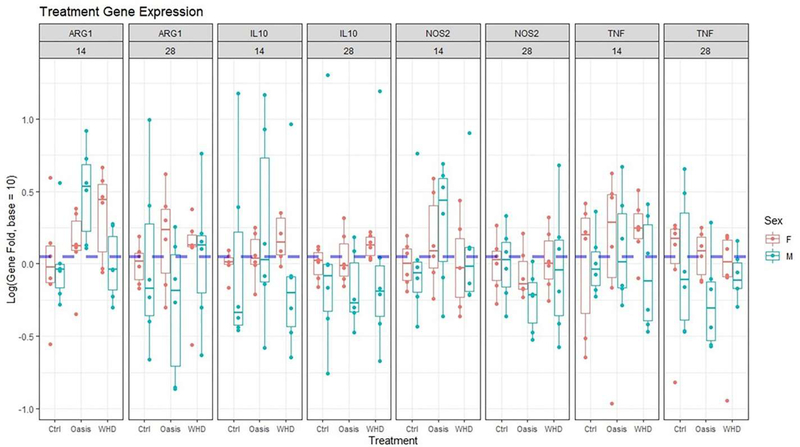
Treatment differences in gene expression faceted by sex, treatment, day, and gene. No significant differences were noted.